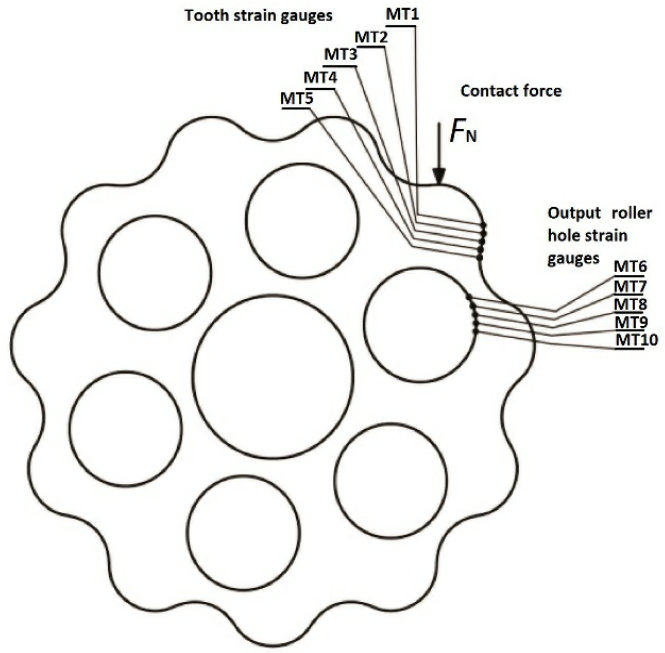
Figure 6. Position of the glued strain gauges.